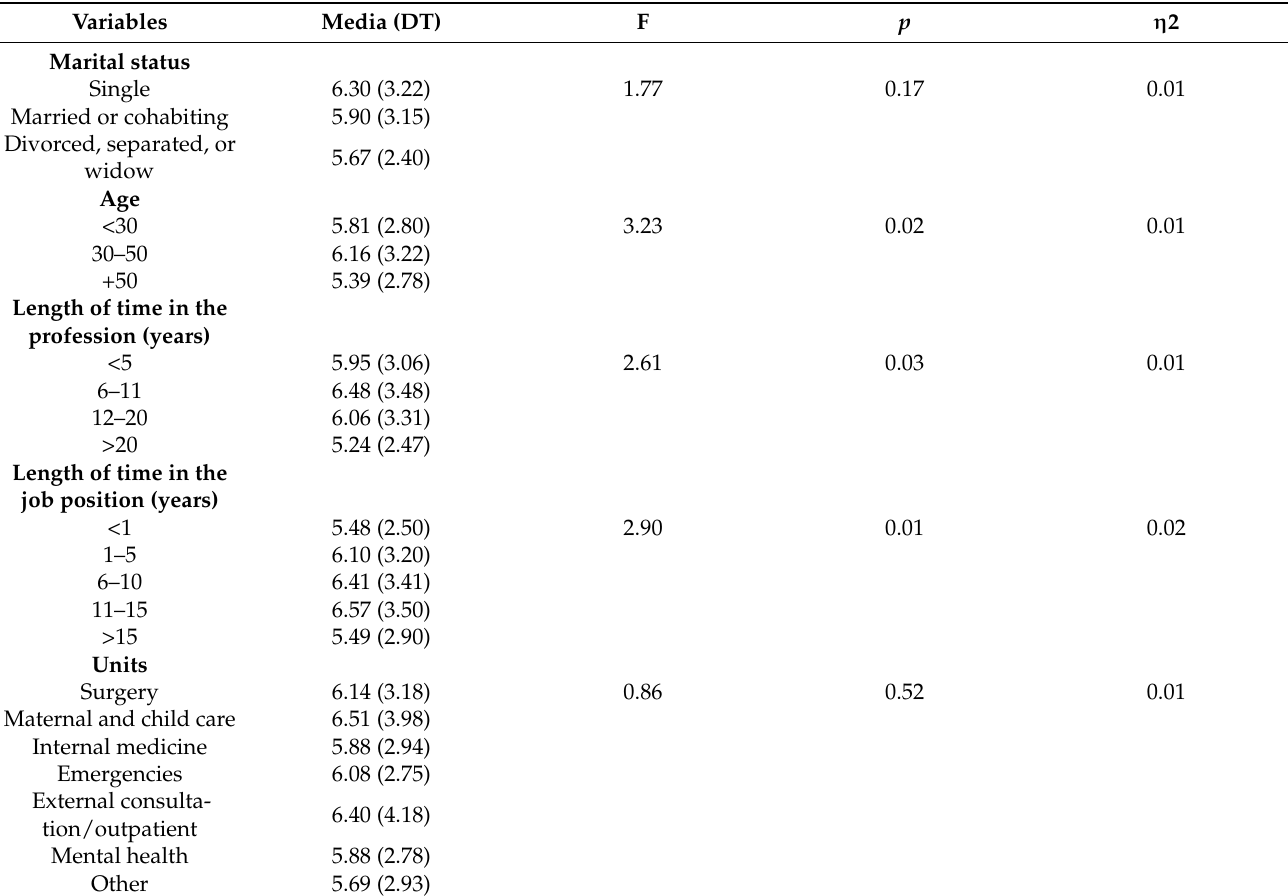
Table 3. ANOVA for personal lateral violence.